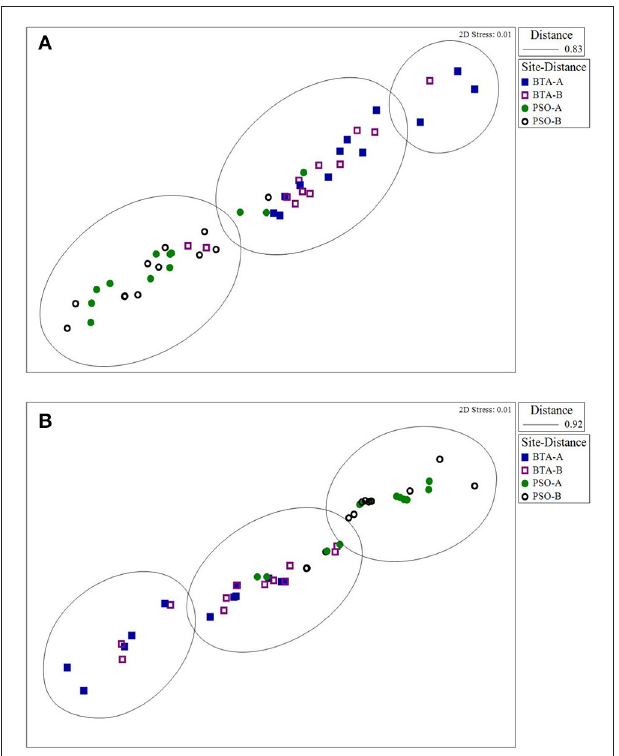
FIGURE 7 | Non-metric multidimensional scaling (nMDS) plot for sand grain size (A) and silt-clay (B) by time, site, and distance zones. Clusters are based on a Euclidean distance cutoff level of 0.83 (A) and 0.92 (B) . Ordination diagram shows sediment particle grain size distribution on first two dimensions, X axis (nMSD1) and Y axis